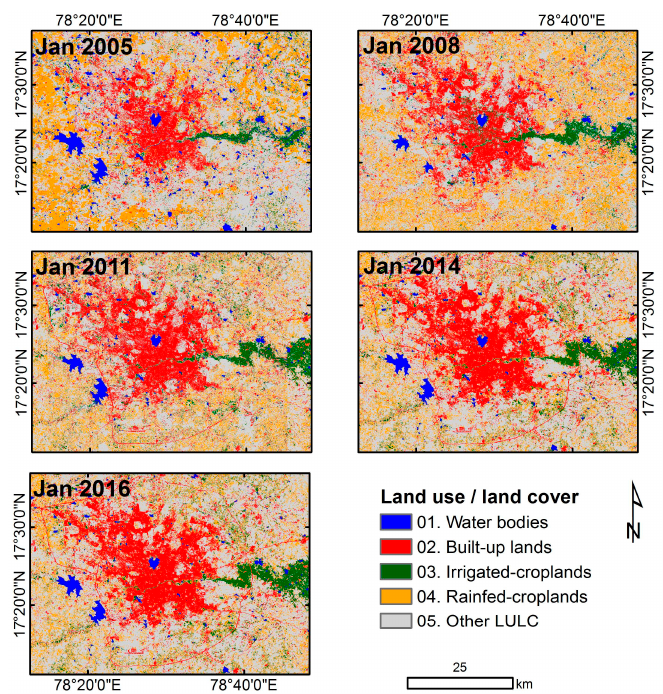
Figure 5. The five land-use/land-cover (LULC) classes developed, based on Landsat-8, IRS-P6, and MODIS time series data, for the years 2005, 2008, 2011, 2014, and 2016.